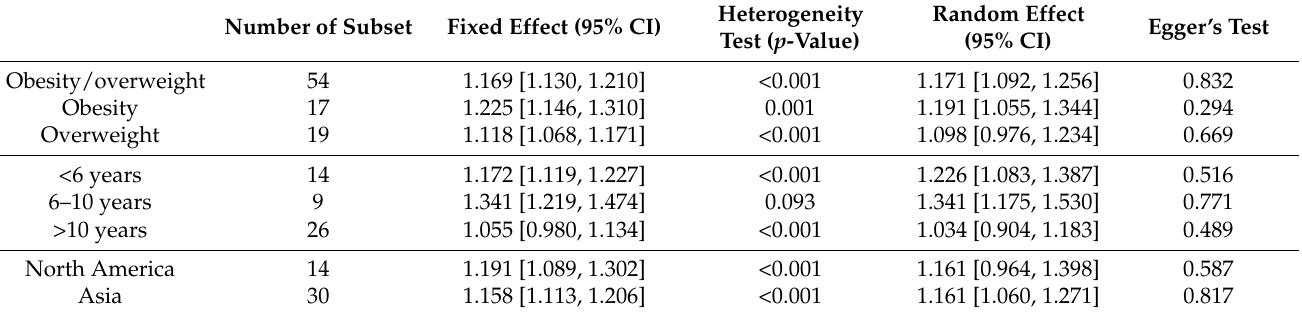
Table 2. Meta-analysis for the odds ratio of obesity/overweight according to the short sleep duration.